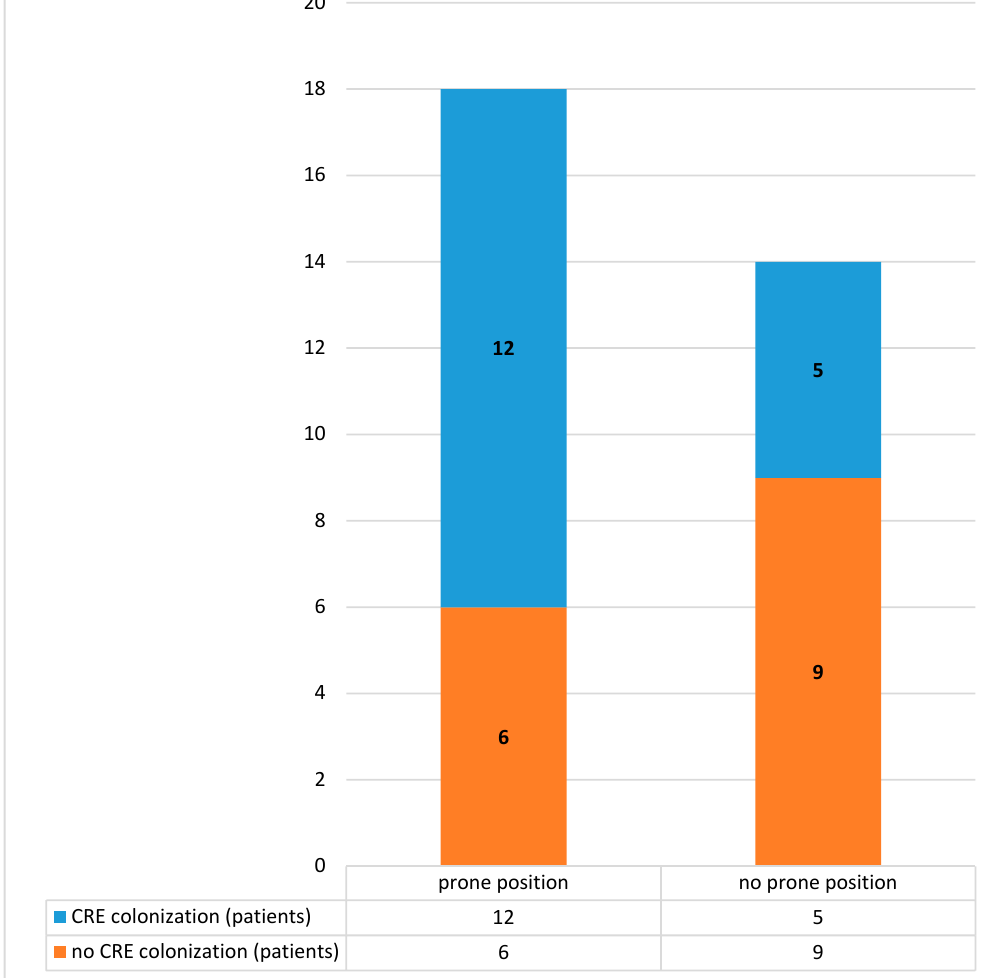
Figure 3. Data about the acute respiratory distress syndrome (ARDS) coronavirus disease 2019 (COVID-19) patients pronate and not pronate and CRE colonization.